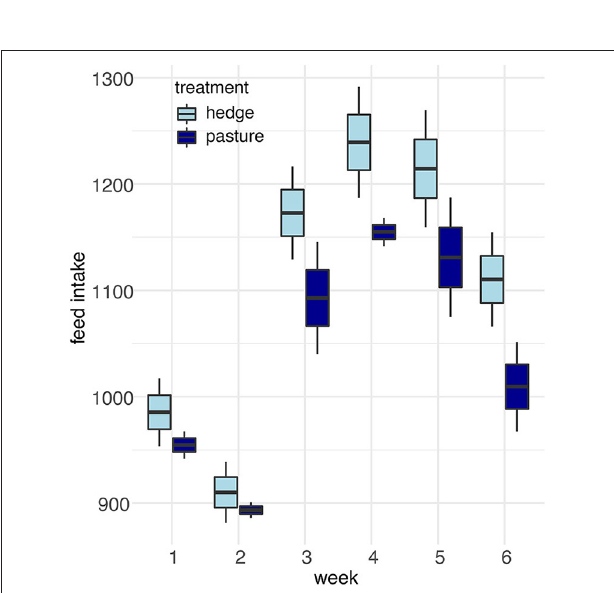
FIGURE 4 | Effect of treatment (hedge access) on Cornish cross feed intake. There was no significant difference in the feed intake of Cornish cross raised with hedges compared to Cornish cross raised in bare pasture. LMEM Average feed intake per bird ∼ treatment + week + treatment * week + average bird weight +